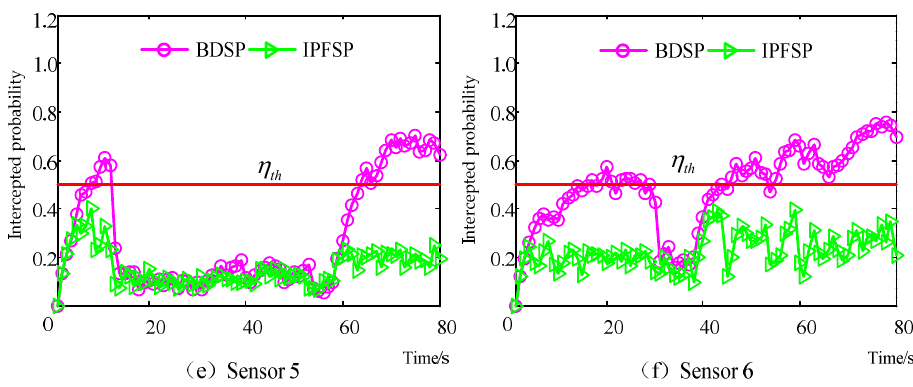
Figure 16. Sensor intercept probability under different scheduling policies. ( a ) Sensor 1; ( b ) Sensor 2; ( c ) Sensor 3; ( d ) Sensor 4; ( e ) Sensor 5; ( f ) Sensor 6.